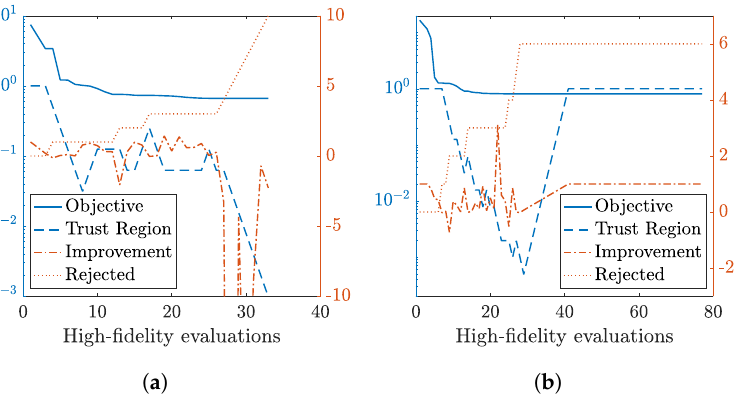
Figure 17. Performance of multi-fidelity model within airfoil design. ( a ) Rigid 7-DoF Kulfan; ( b ) Aeroelastic 7-DoF